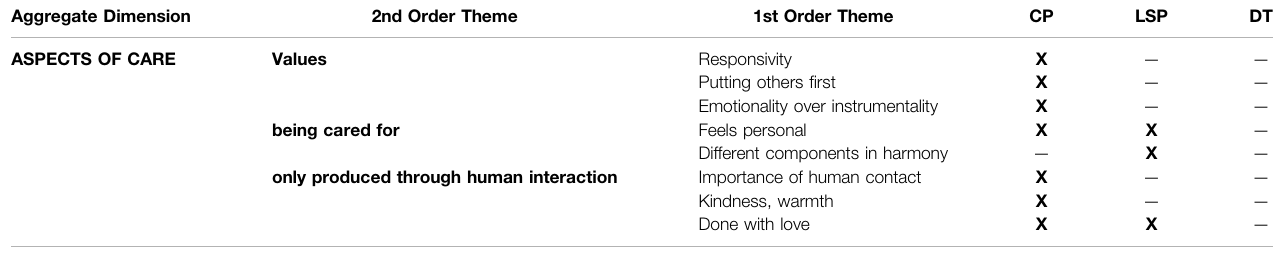
TABLE 3 | Qualities of a useful robot. Aggregate